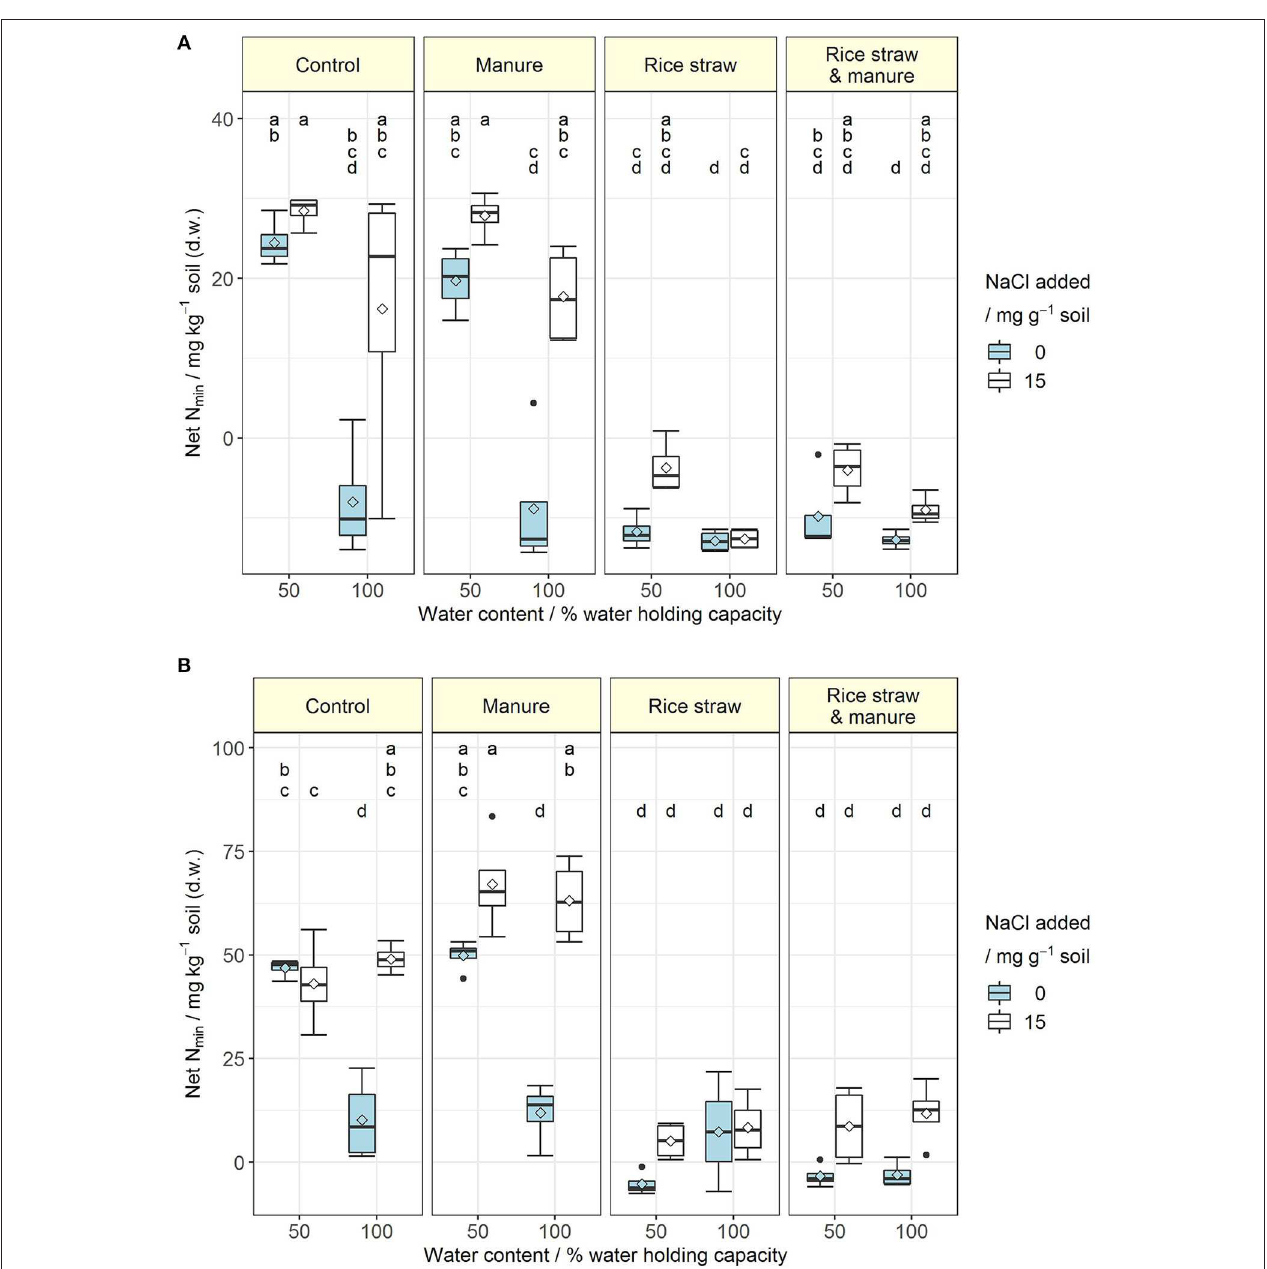
FIGURE 1 | (A,B) Net N mineralisation (mg inorganic N kg − 1 soil) at the end of the incubation for soil A (A) and soil B (B) at 50 and 100% water holding capacity and with (15mg NaCl g − 1 soil) or without salt addition after manure, rice straw or manure plus rice straw addition. Diamonds indicate the mean and letters indicate significant differences at p < 0.05 (Rank-based ANOVA for soil A and ANOVA for soil B; n =